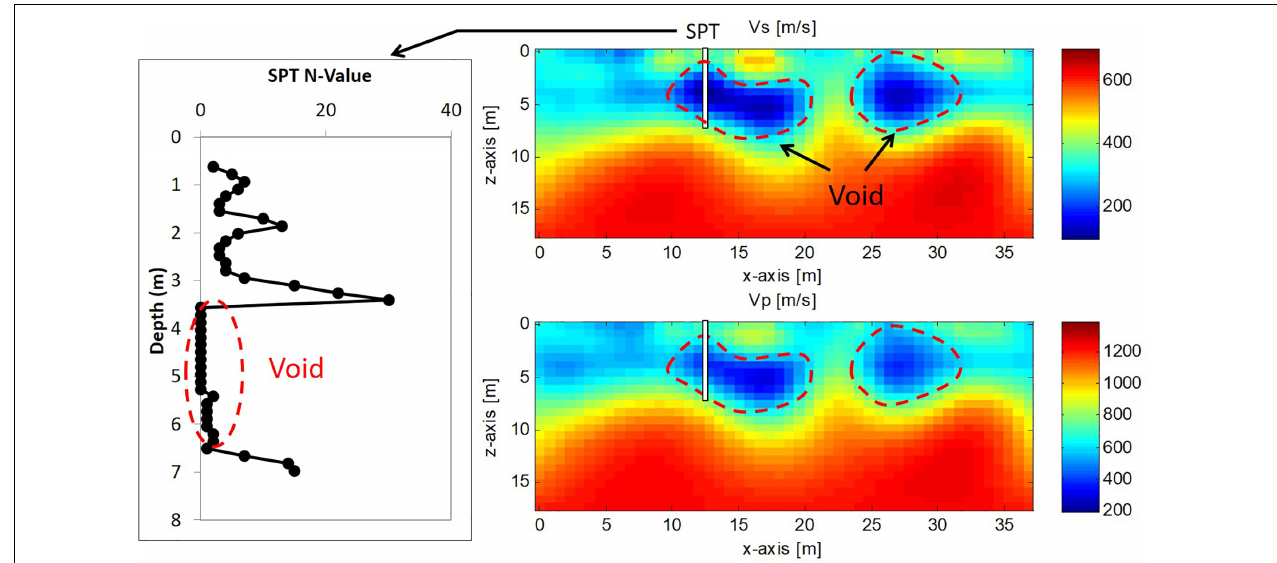
FIGURE 7 | Comparison of FWI seismic and invasive SPT. The inverted Vs and SPT results both show a void at about 4–7 m depth and top of bedrock at 7 m depth (after Tran et al., 2020).